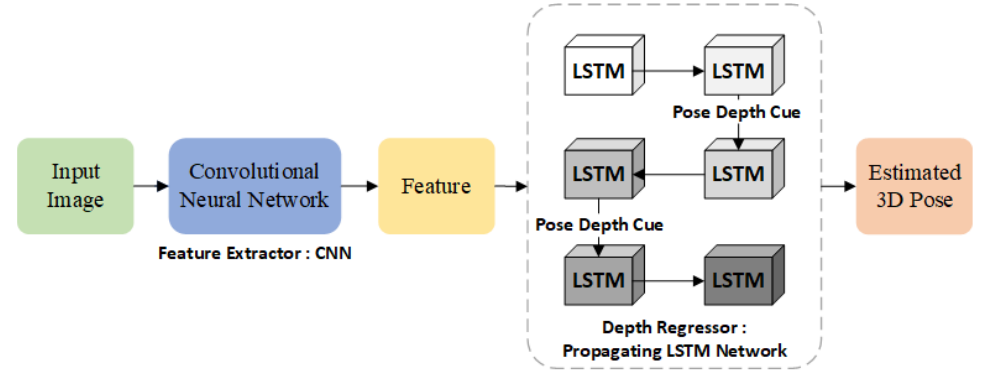
Figure 4. Illustration of Lee’s approach with pose depth